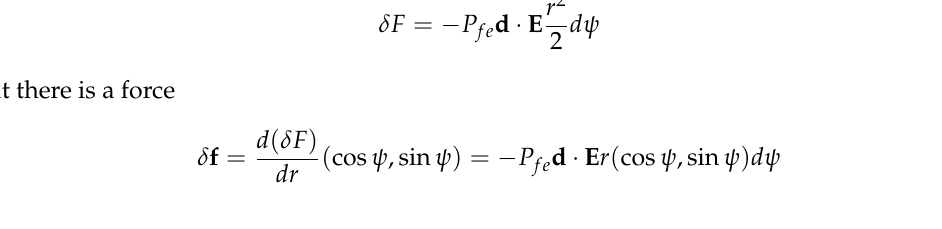
Figure 10. Configurations of dowsons d+ and d- and their motions in electric field. Direction of forces f indicated here are given by Equation (36) with P fe > 0. ( a ) Definition of variables r, ψ and ϕ . ( b – j ) Direction of the force action on dowsons in several configurations. ( k ) Energy density (given in Equation (33)) in the orthoradial configuration of the dowson